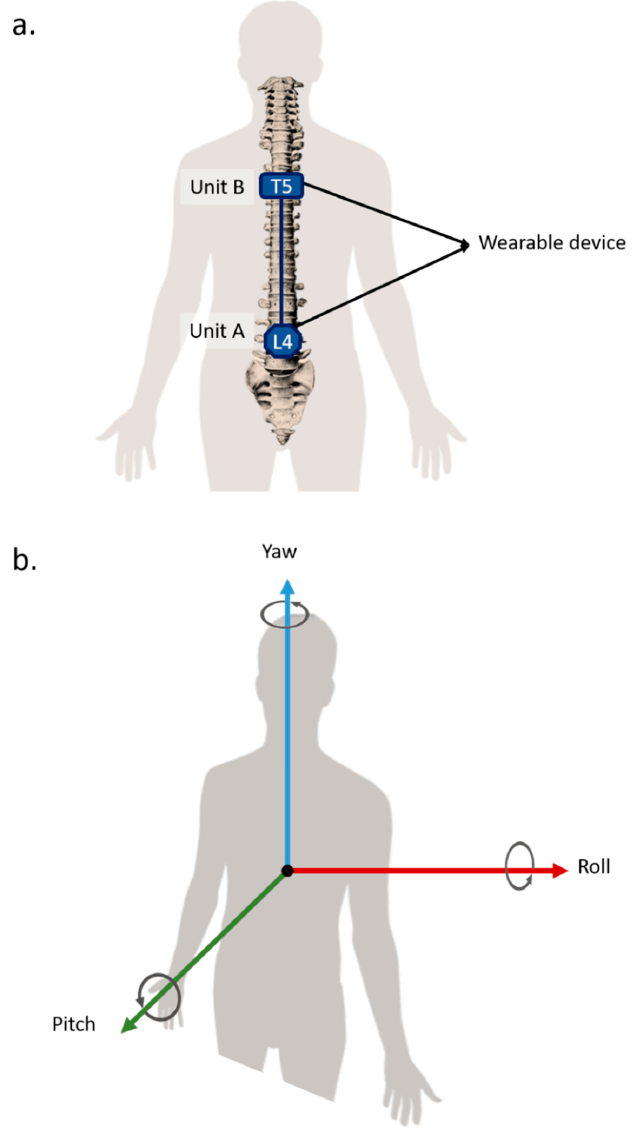
Figure 2. Wearable device and axis: ( a ) Wearable device positioned in T5 and L4 vertebrae. ( b ) Pitch, roll, and yaw axes definition used for the wearable device. These images are licensed under a Creative Commons Attribution-Share Alike license (CC BY—SA) [32,33].